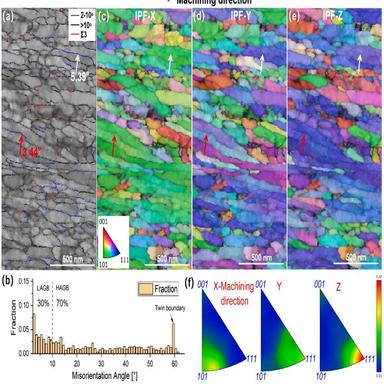
(a) TKD band contrast and grain boundary overlaid map, (c–e) orientation distribution maps, and (f) inversed pole figures of the ultrafine-grained layer; (b) shows the grain boundaries misorientation distribution within the layer.